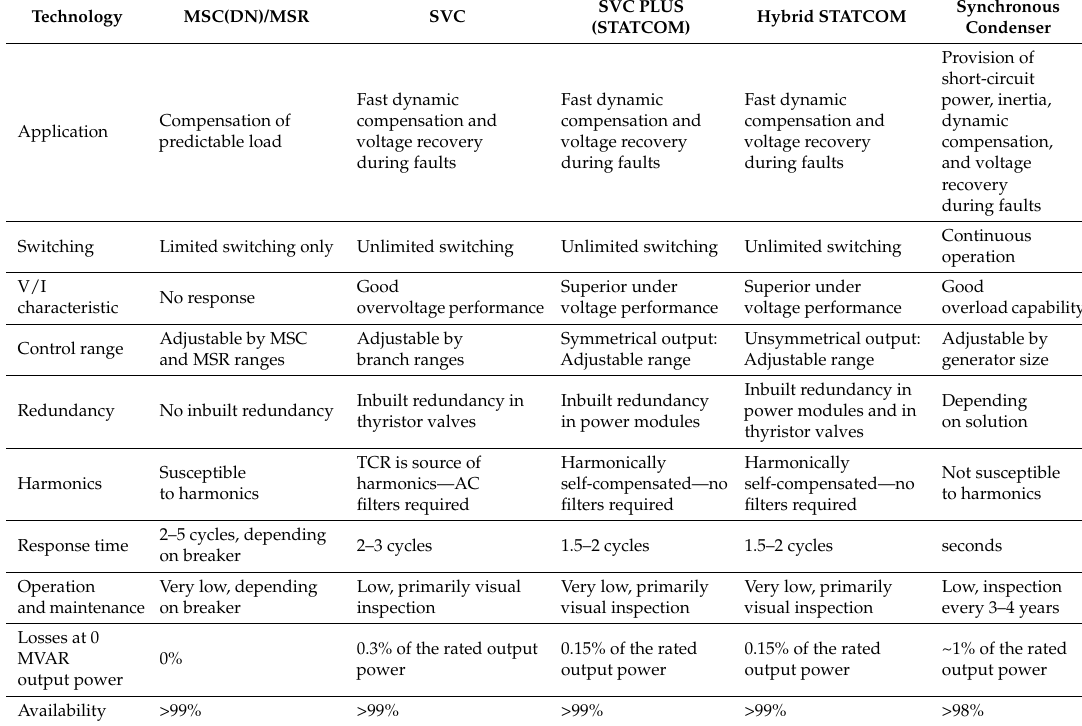
Table 2. Comparison of the advanced technology solution for the reactive power compensation